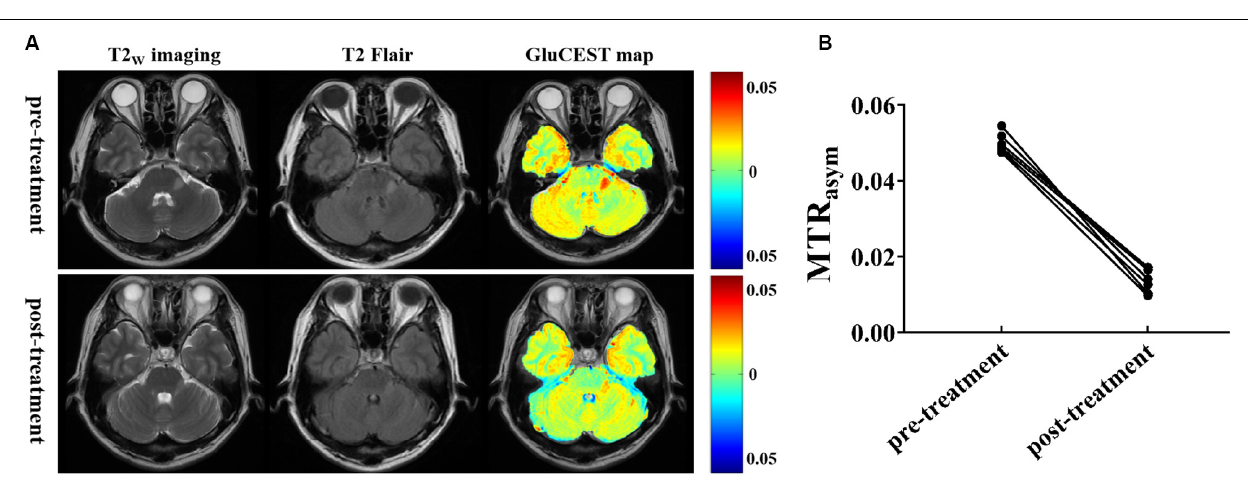
Frontiers in Neuroscience | www.frontiersin.org